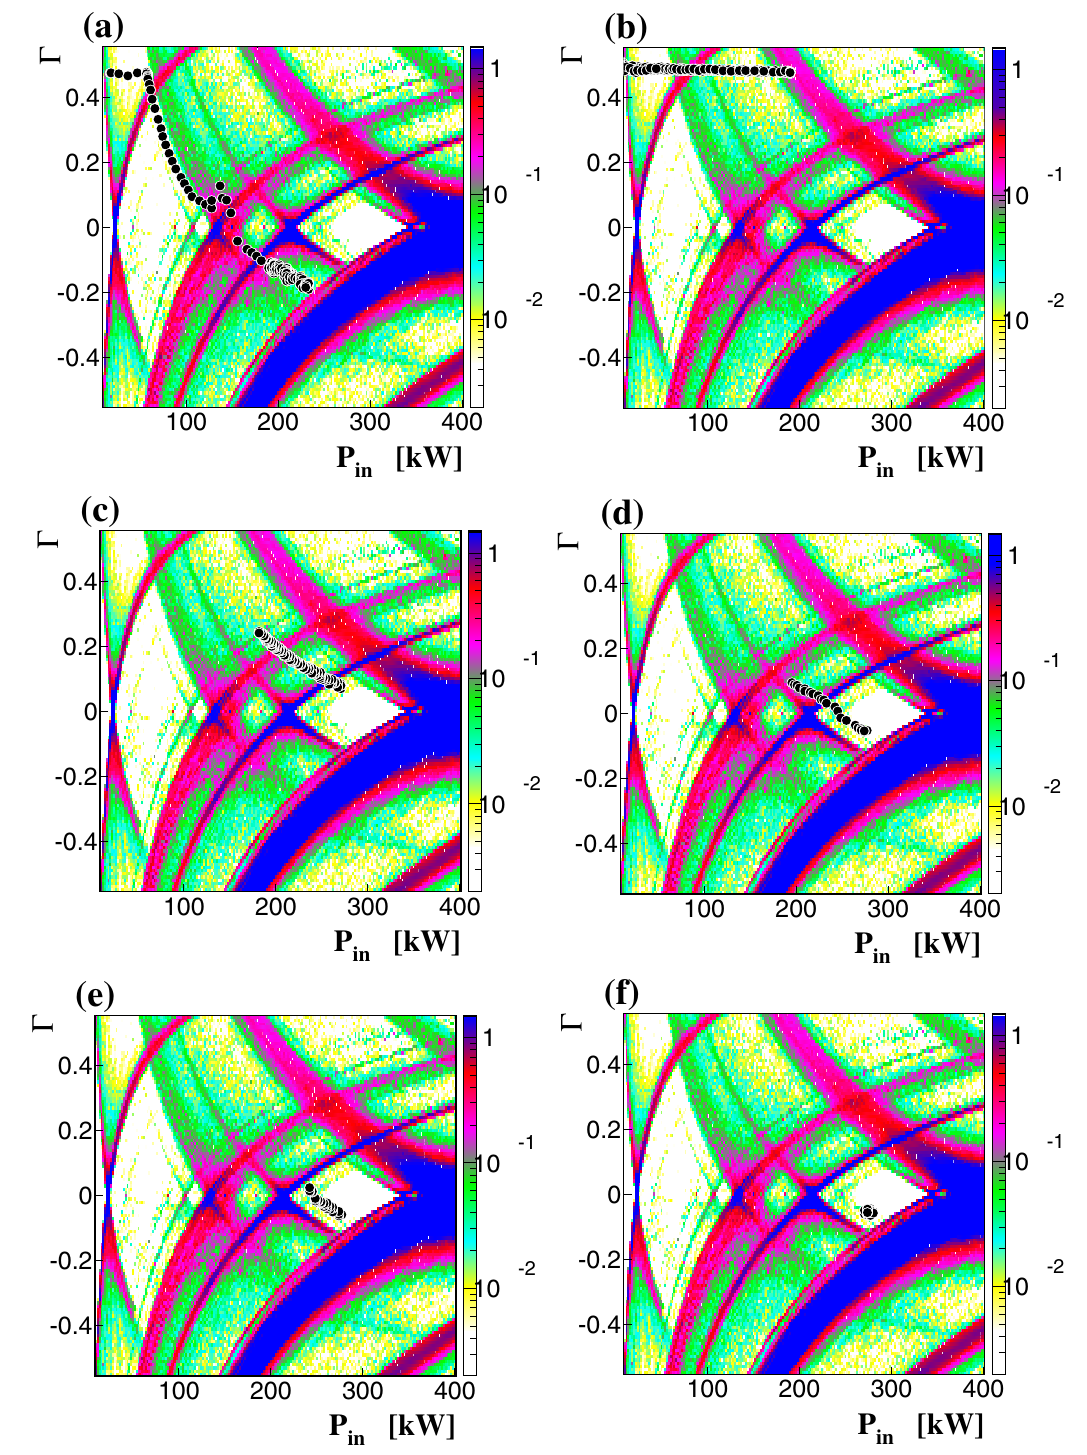
FIG. 4. (Color) Trajectories of the operating point of CavityM. The circles are measurements of the input rf power and the reflection coefficient in the periods of (a) the beam recovery, (b) the rf conditioning without a beam [for the comparison shown in Fig. 5(a)], (c) the beam decreasing without beam injection in a physics run [for the comparison shown in Fig. 5(b)], (d) the machine study to search for a new operating region [for the comparison shown in Fig. 5(c)], (e) the physics run in the CIM mode without the beam loading feedback, and (f) the physics run in the CIM mode with the beam loading feedback. The cavity voltage of CavityM was 0.27 MVand 0.39 MV for (a) and (c), respectively, and 0.34 MV for (d), (e), and